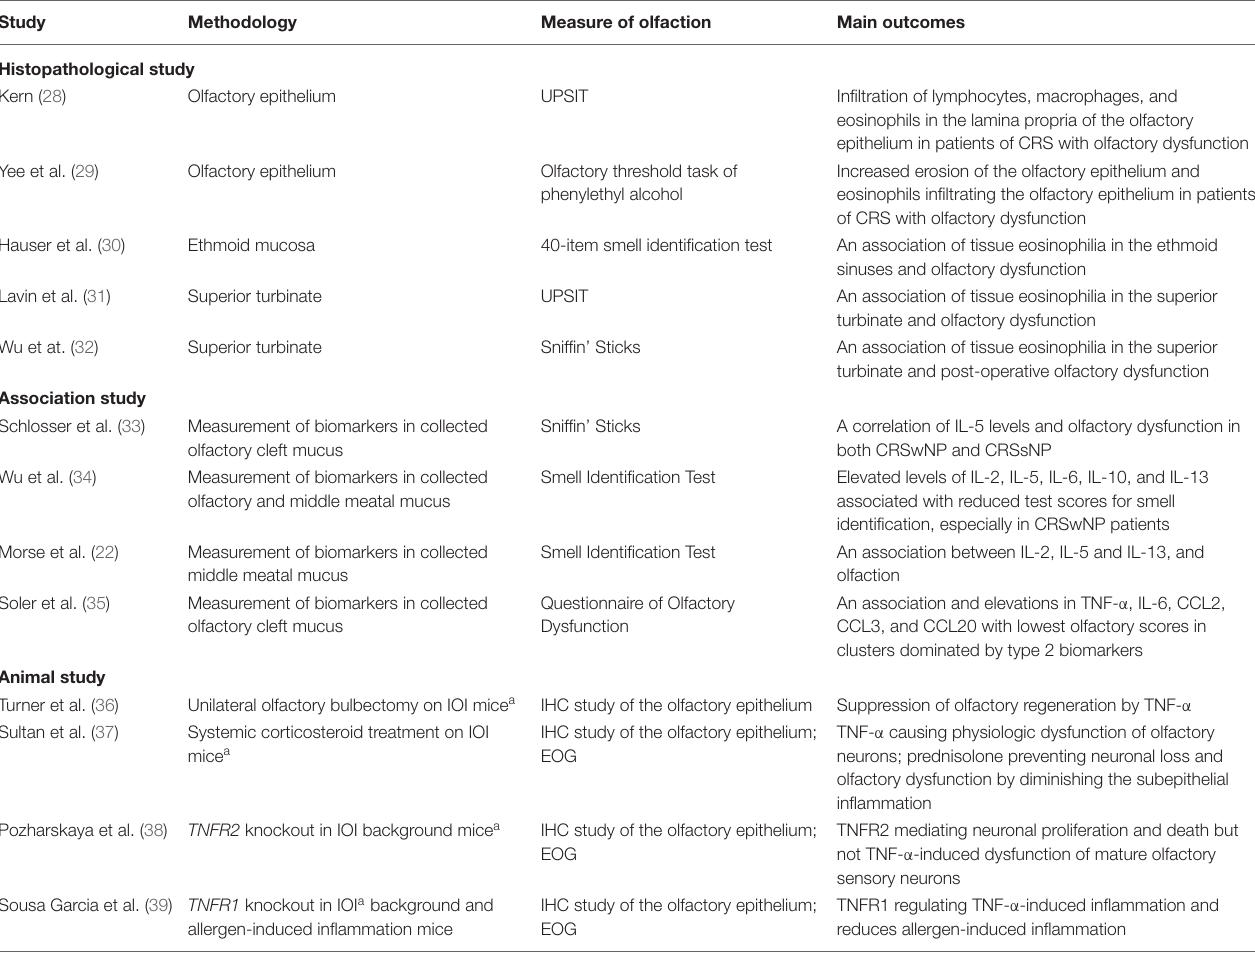
TABLE 1 | Summary of the studies on the mechanisms of olfactory dysfunction in